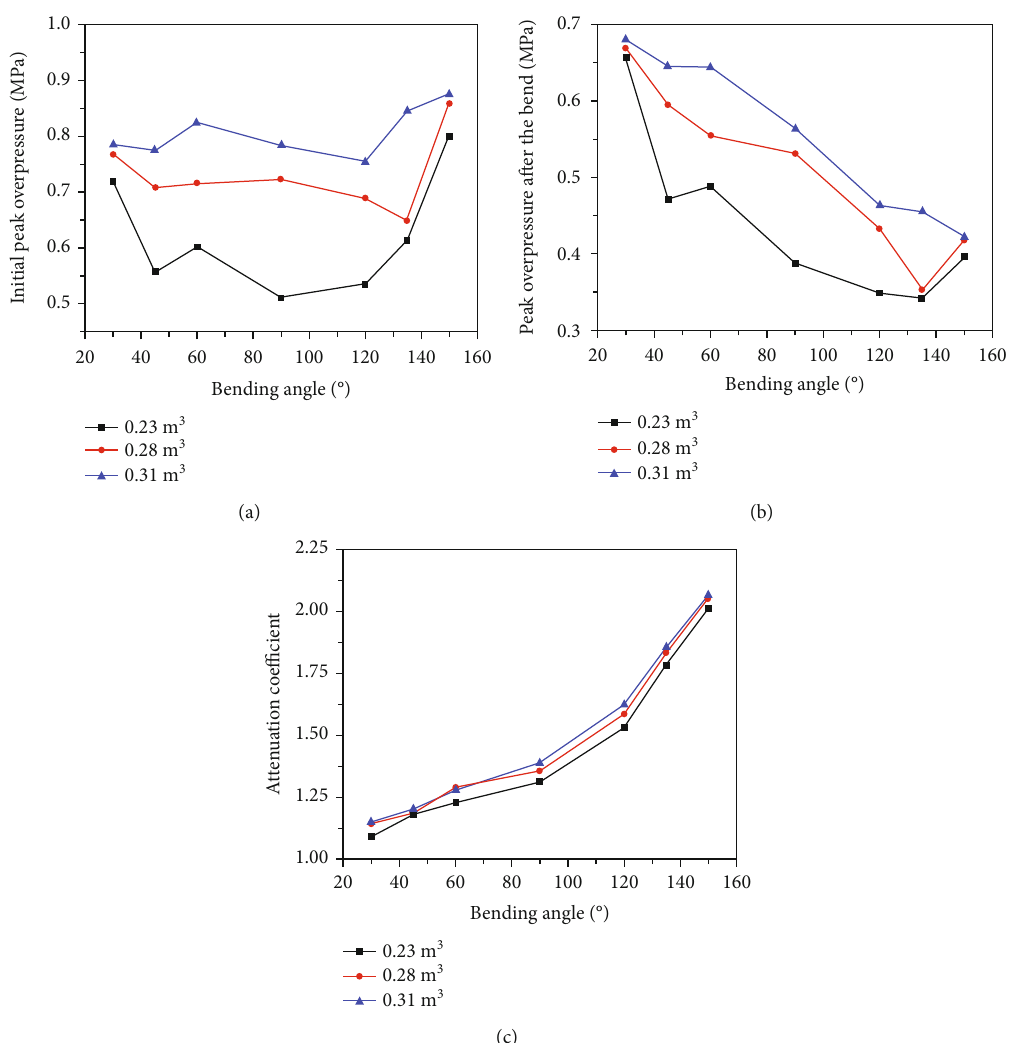
Figure 6: Relationships between initial peak overpressure, peak overpressure after the bend, attenuation coe ffi cient, and bending